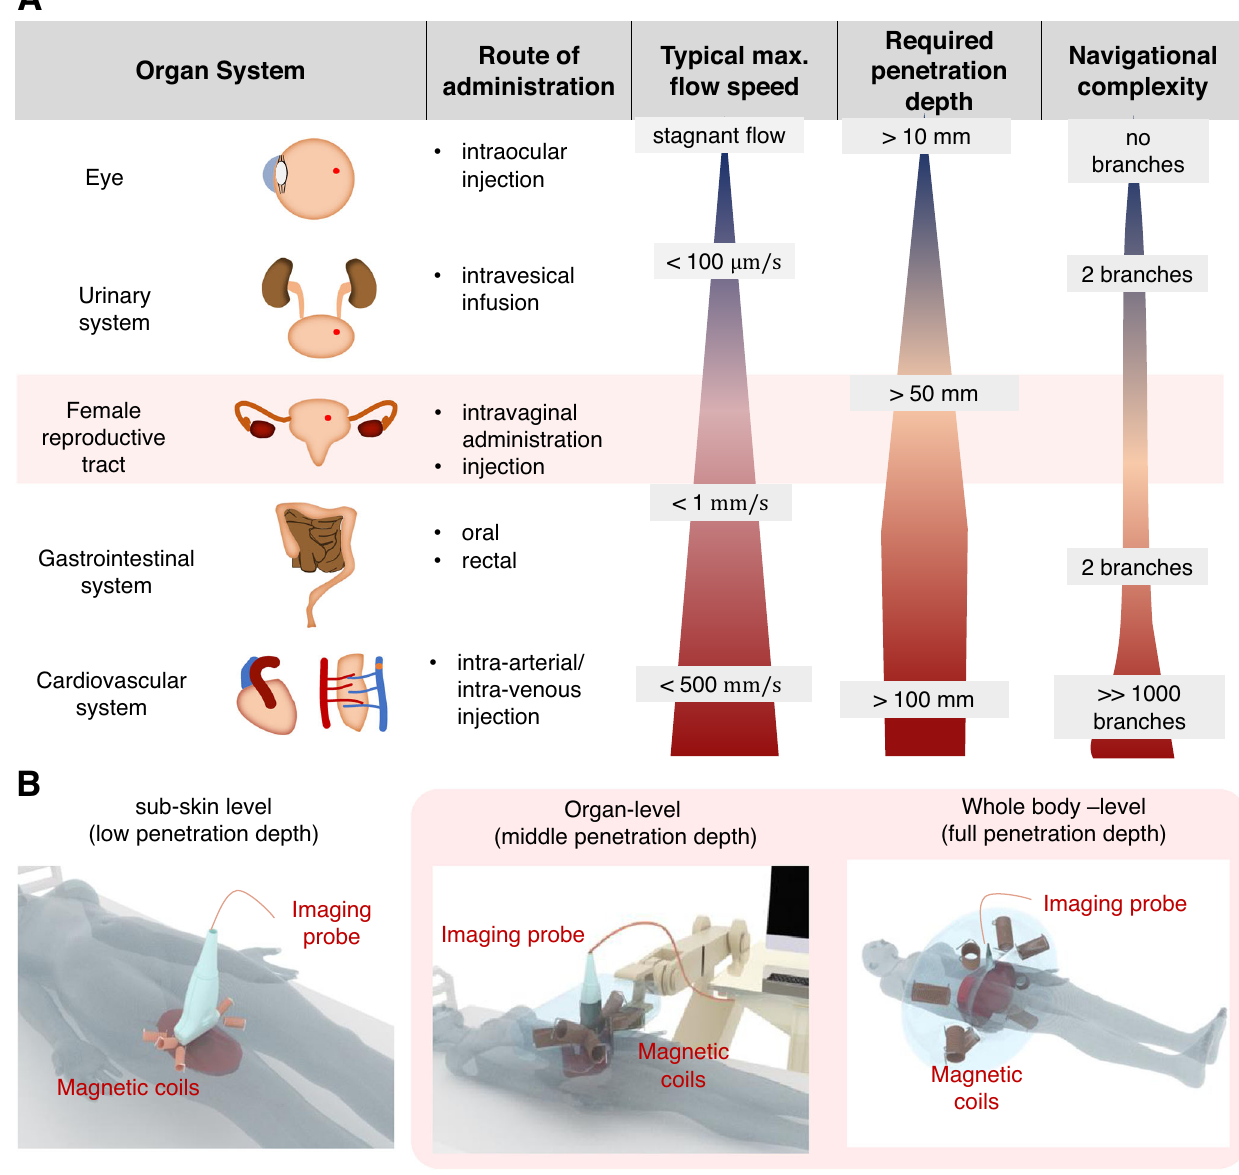
Fig. 2 | Overview of medical microrobotics targeting different organ systems. A Administrationroutesforalternativeapplicationssuchastargeteddrugdelivery, microsurgery, local sensing, microbiopsy, and tissue engineering, highlighting the key challenges for operating such microrobots through these administration routes (e.g., required propulsion forces, required penetration depth for both imaging and actuation, and complexity of the environment in which the